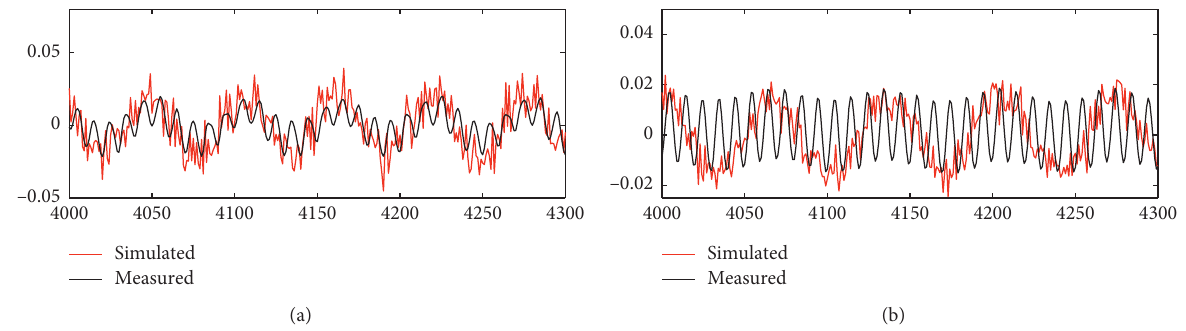
Figure 15: Measured signal and simulated source signals with noise: (a) motor A simulated vs measured at a speed of 100%; (b) motor B simulated vs measured at a speed of 100%.